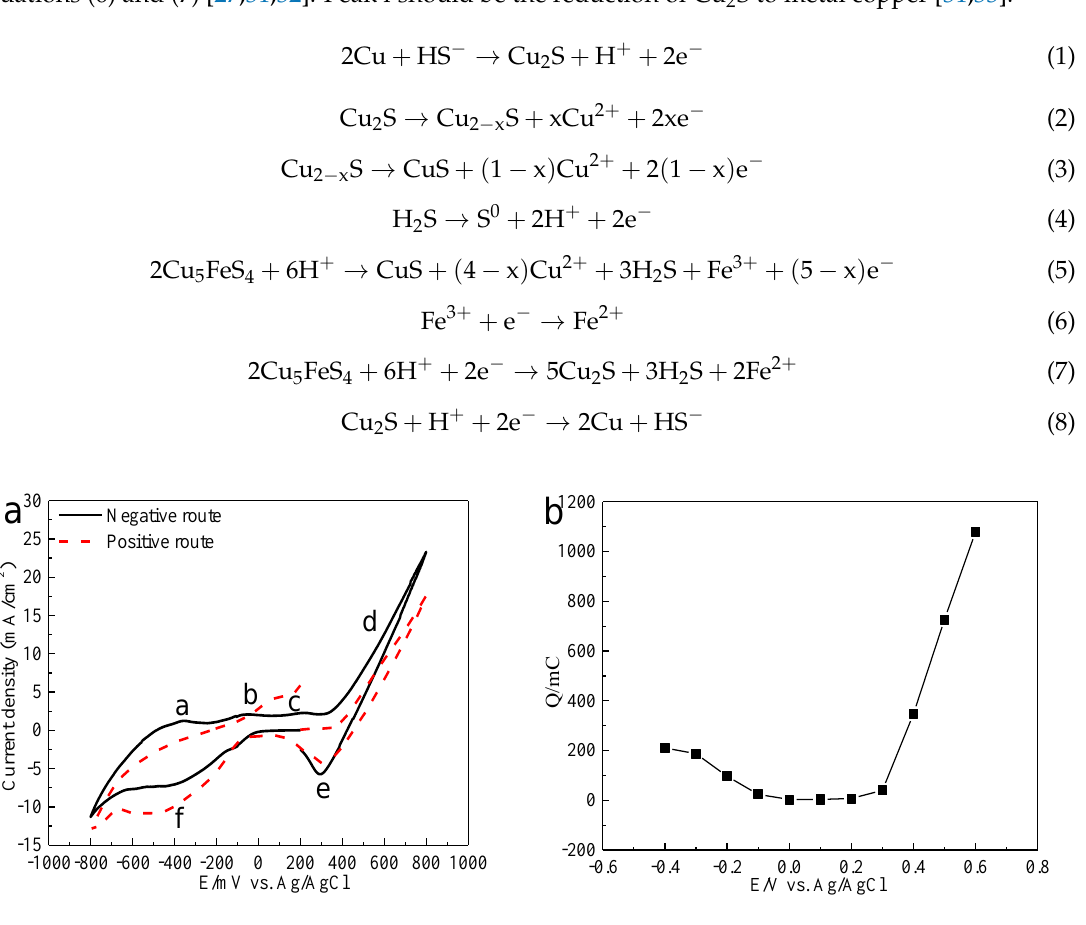
Figure 8. Electrochemistry analysis of bornite in 9K bacterial culture medium (Conventional three-electrode system on a Princeton Model 283 Potentiostat, EG&G of Princeton Applied Research): ( a ) Cyclic voltammograms of bornite electrode (Scan rate 20 mV/s); ( b ) Relationship between the total charges (evaluated from the current-time curves with duration time of 240 s) and applied potentials.